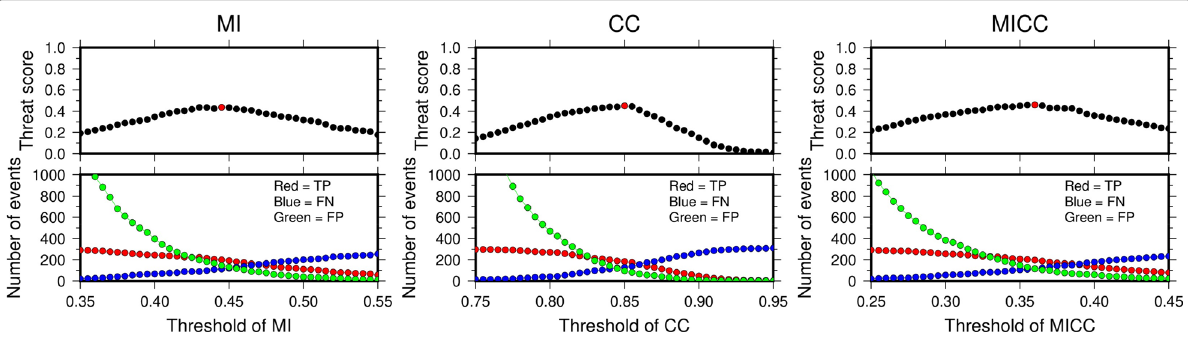
Fig. 12 The threat score and the number of TP, FP, and FN events. The upper panels show the threat score for three indices. Horizontal axis corresponding to the threshold values. Red, blue, and green circles in the lower panels show the number of TP, FN, and FP events for each threshold value